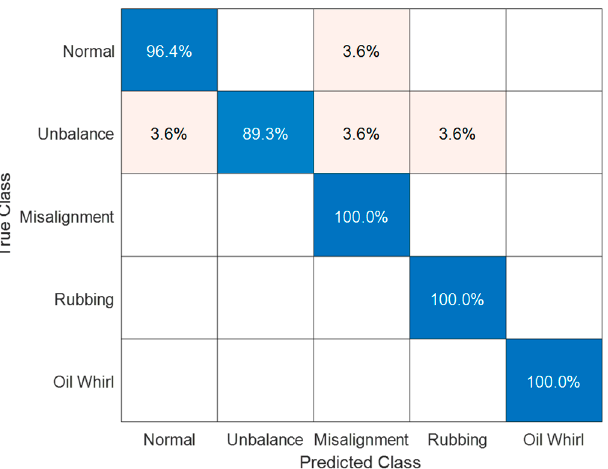
Figure 18. Test confusion matrix of SVM (cubic) on automatically extracted features from the pretrained deep learning model with 12 virtual sensors on RK4.